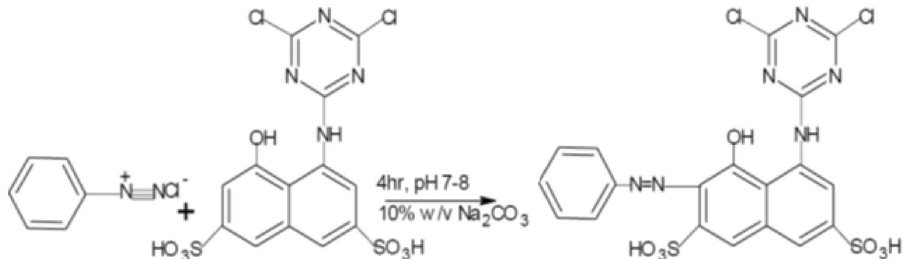
Fig. 3 CHA dye synthesis from diazotized anilines and the coupling